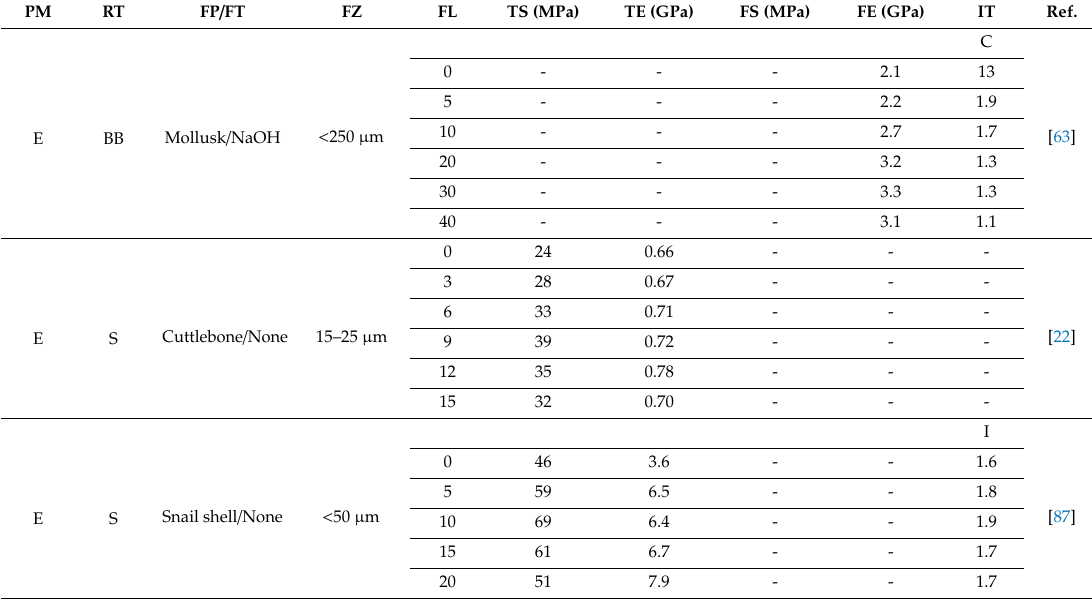
Table 8. Summary of thermoset polymers containing seashell fillers (all by solution-mixing technique). PM